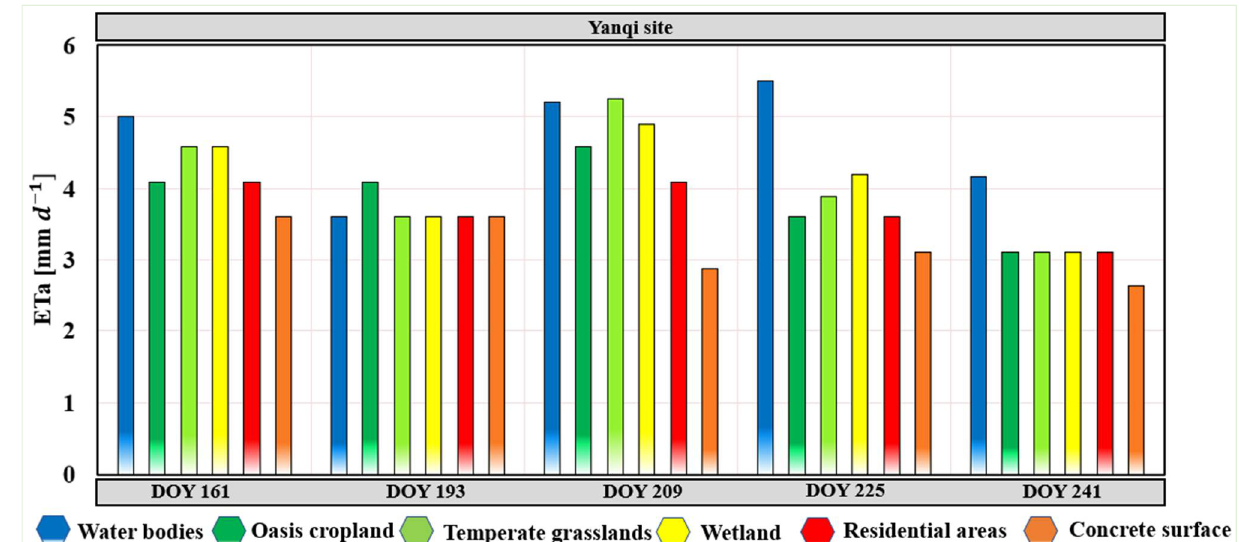
Figure 10. Summer season daily mean ETa over Yanqi land cover canopy.